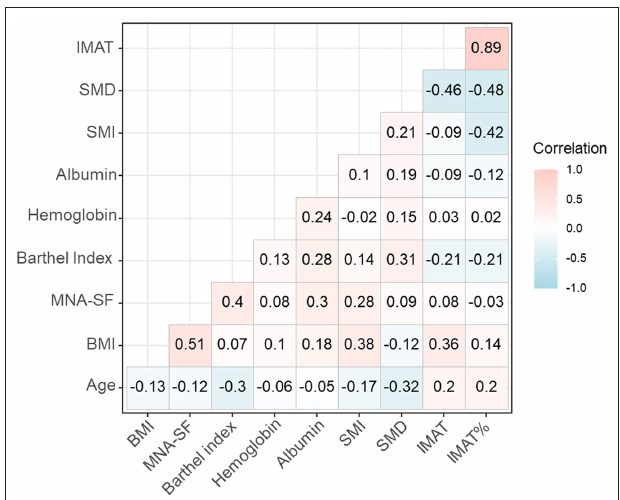
FIGURE 1 | The correlation coefficients of SMI, SMD, IMAT, and IMAT% with other variables. BMI, body mass index; IMAT, intermuscular adipose tissue; IMAT%, percentage of intermuscular adipose tissue; MNA-SF, mini nutritional assessment short form; SMD, skeletal muscle radiodensity; SMI, skeletal muscle